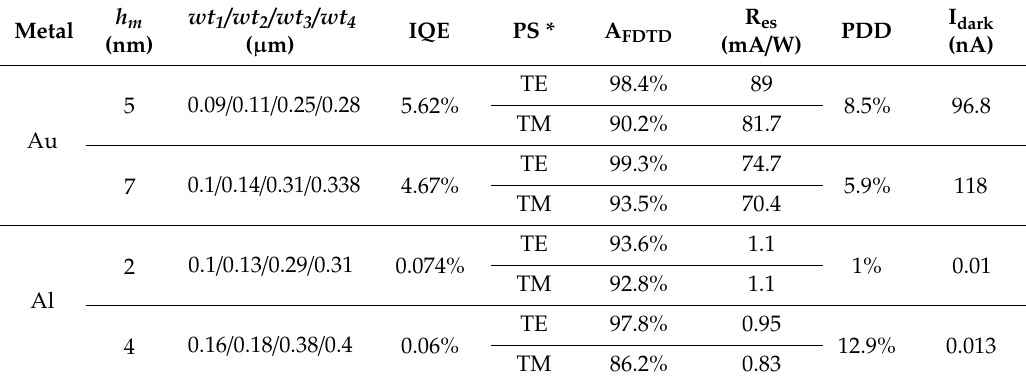
Table 2. Structure parameters of the single layer metal configuration and performances at 2 µ m.